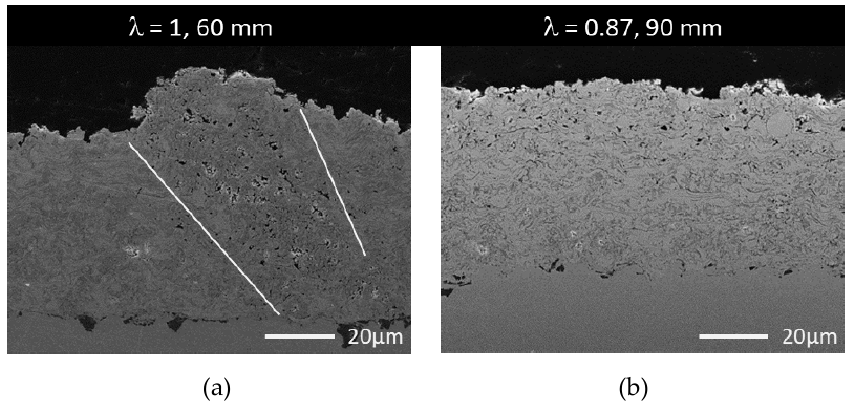
Figure 5. SEM image of NiCr coatings. ( a ) A typical cone-shaped defect found in NiCr coatings at 60 mm spray distances ( λ = 1). ( b ) Spray parametres: λ = 0.87 (<1); spray distance = 90 mm. Taken from [21].